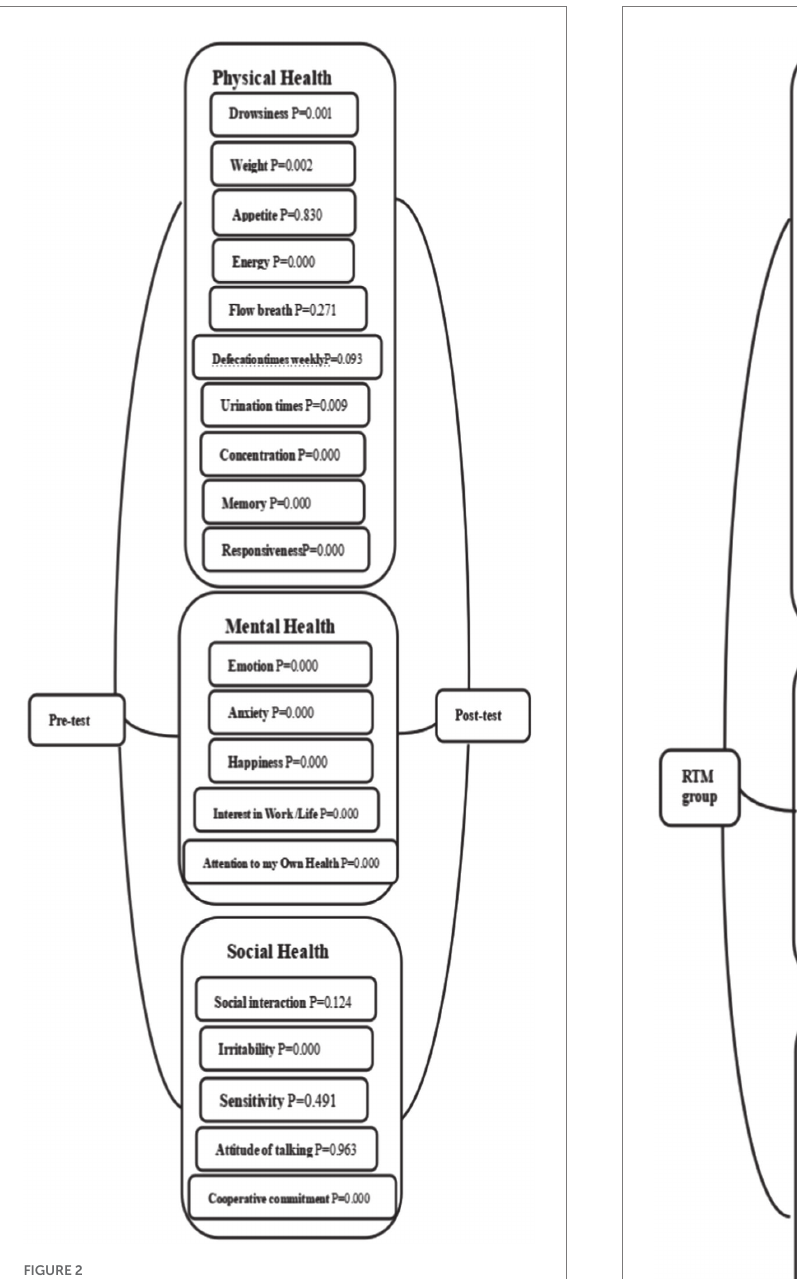
FIGURE 2 Statistical analysis of pre-test and post-test of observation group.